Question: Sum up the contents of this chart in one sentence.
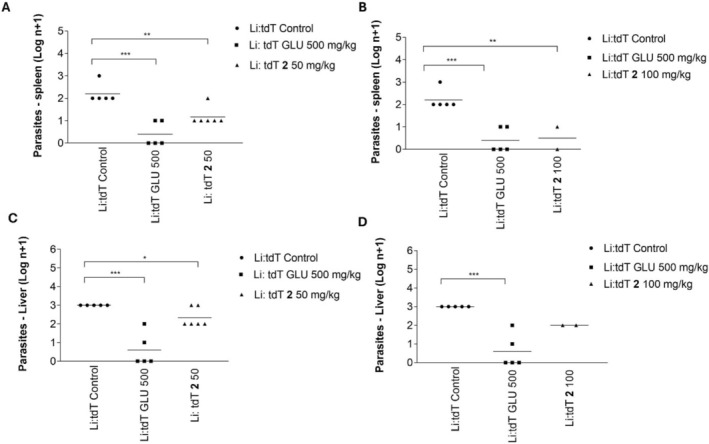
Answer: In vivo efficacy of 2 (50 mg/kg/day and 100 mg/kg/day) in a mice model of visceral leishmaniasis. Meglumine antimoniate (500 mg/kg/day) was used as a positive control, and a group was left untreated as the negative control. The antileishmanial efficacy was evaluated through the number of viable parasites recovered from the spleen (A and B) and the liver (C and D) of mice treated with 2 and meglumine antimoniate, when compared to the untreated control (a logarithmic scale was used for the graphical representation, [Log n + 1]). Groups receiving treatment were compared to the negative control using one‐way analysis of variance with Bonferroni post hoc test. Statistical analysis was performed using ANOVA followed by Bonferroni's multiple comparisons test (* p < 0.05; ** p < 0.01; *** p < 0.001). GLU: Meglumine antimoniate. Li:TdT : Transfected L. infantum::TdTomato parasites.